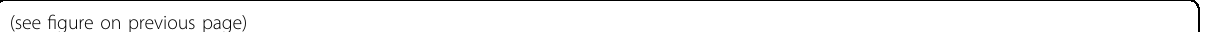
Fig. 5 ATO promotes TFEB-dependent lysosome biosynthesis and the fusion between autophagosomes and lysosomes in macrophages. A – E RAW264.7 cells were treated with 3-MA (2.5 mM) or NAC (5 mM) for 2 h following ATO treatment (2.5 μ M, 2 h). Then LAMP1 level in treated cells were analyzed by immunostaining ( a , b ), RT-qPCR ( c ), and western blots ( D , E ). Scale bars = 10 μ m. F , G LysoTracker staining in RAW264.7 cells treated with or without 2.5 μ M ATO for 2 h. Scale bars = 20 μ m. H , I RAW264.7 cells were transfected with GFPmRFP-LC3 for 48 h and then treated with ATO (2.5 μ M) for 2 h. The numbers of acidi fi ed autophagosomes (GFP − RFP + ) versus neutral autophagosomes(GFP + RFP + ) per cell were examined and quanti fi ed by confocal microscopy. Scale bars = 20 μ m. *** p < 0.001 vs. autophagosomes of ATO group. aa p < 0.01, aaa p < 0.001 vs. speci fi ed group. J – L RAW264.7 cells were transfected with scrambled or TFEB siRNA for 48 h, and then treated with ATO (2.5 μ M) for 2 h. J , K Immuno fl uorescence analysis of TFEB effect on lysosomal and autophagy dysfunction in RAW264.7 cells as assessed LC3 (green), LAMP1 (red), p62 (green) and DAPI (blue) following indicated treatments. Scale bars = 20 μ m. aaa p < 0.001 vs. speci fi ed group. L WB analysis of TFEB effect on lysosomal and autophagy dysfunction in RAW264.7 cells as assessed autophagy speci fi c proteins following indicated treatments. Data were expressed as mean ± SD from 3 independent experiments. * p < 0.05, ** p < 0.01, *** p < 0.001, and ns means non-signi fi